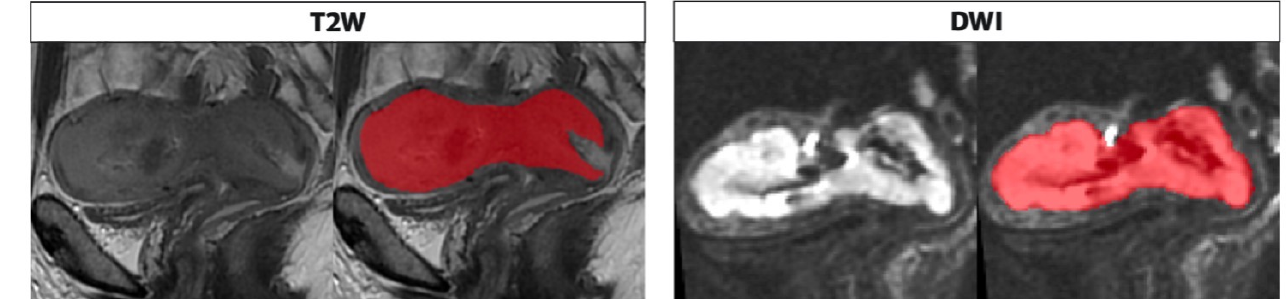
Figure 3. Segmentation performed on T2 and DWI sequences in the sagittal plane along the tumor boundary. The endometrial cavity is replaced by solid heteroplastic tissue characterized by intermediate signal intensity in the T2 sequences and high signal compared with the neighboring myometrium in the DWI images; the tumor is bounded by the red area as shown in the figure alongside both sequences as performed in the segmentation process, on the T2 and DWI.